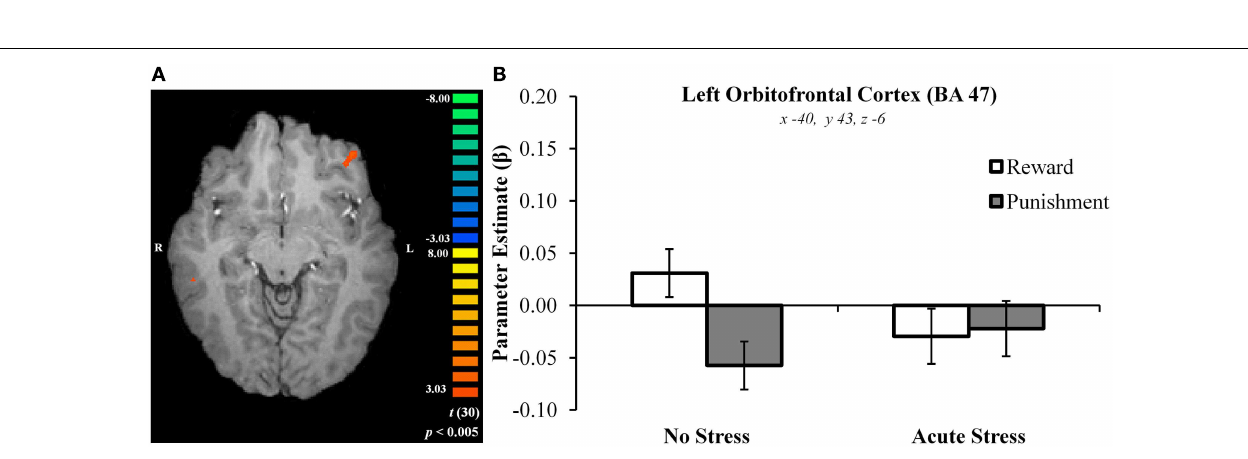
FIGURE 4 | (A) Left orbitofrontal cortex cluster exhibiting greater BOLD signal for no stress over acute stress participants. (B) Left orbitofrontal cortex outcome valence × experimental group parameter estimates.